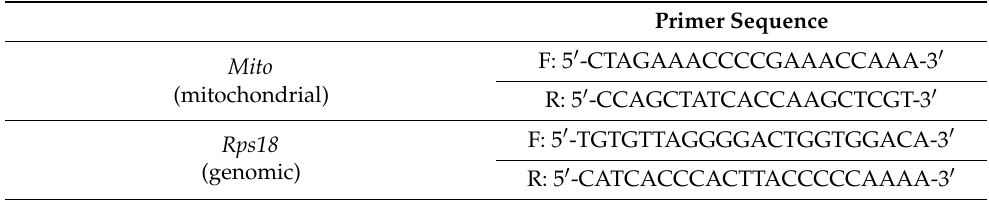
Table 2. The sequences of primers used for the determination of mitochondrial DNA content by